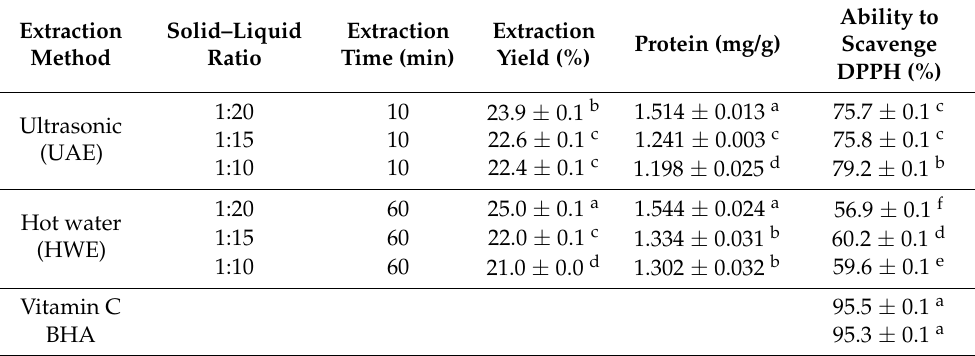
Table 1. Effect of ultrasonic extraction and hot water extraction conditions on yield, total protein, and antioxidant activity of wild bitter gourd.